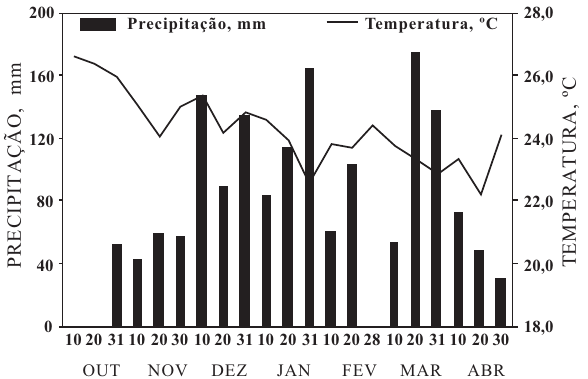
Figura 1. Dados médios, por decêndio, de precipita- ção (mm) e de temperatura (ºC), de outubro de 2002 a abril de 2003, no município de Rio Verde